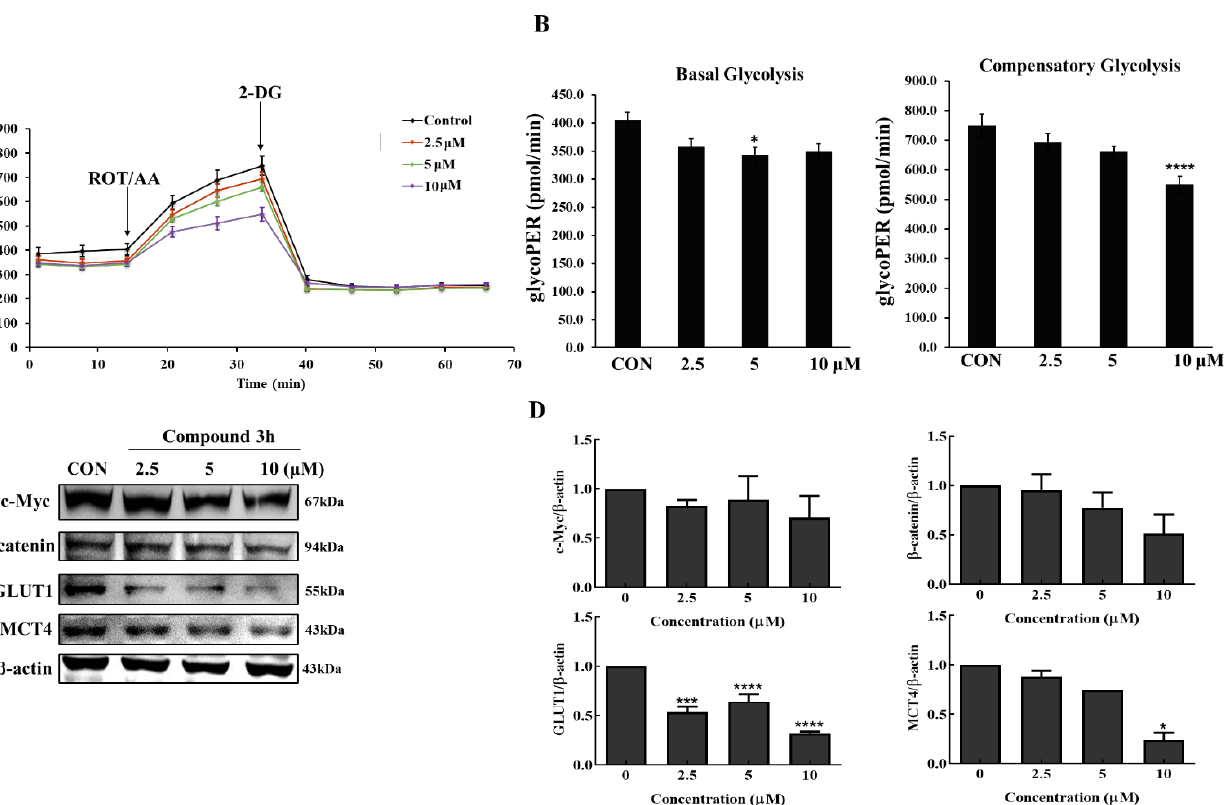
Figure 10. Compound 3h impairs the glycolytic function in LNCaP cells. ( A ) Profile of glycolytic rate assay in LNCaP with specific injections into media. ( B ) Results of Seahorse XF glycolytic rate assay-generator report for basal and compensatory glycolysis (pmol/min). ( C ) Protein expression levels of c-Myc, β -catenin, GLUT1, MCT4 were evaluated by Western blot after compound 3h treatment. ( D ) Representative histograms showing the expression levels of c-Myc, β -catenin, GLUT1, MCT4. The values represent the mean ± SD. * p < 0.05, *** p < 0.001. and **** p < 0.0001. The uncropped blots are shown Supplementary Material.